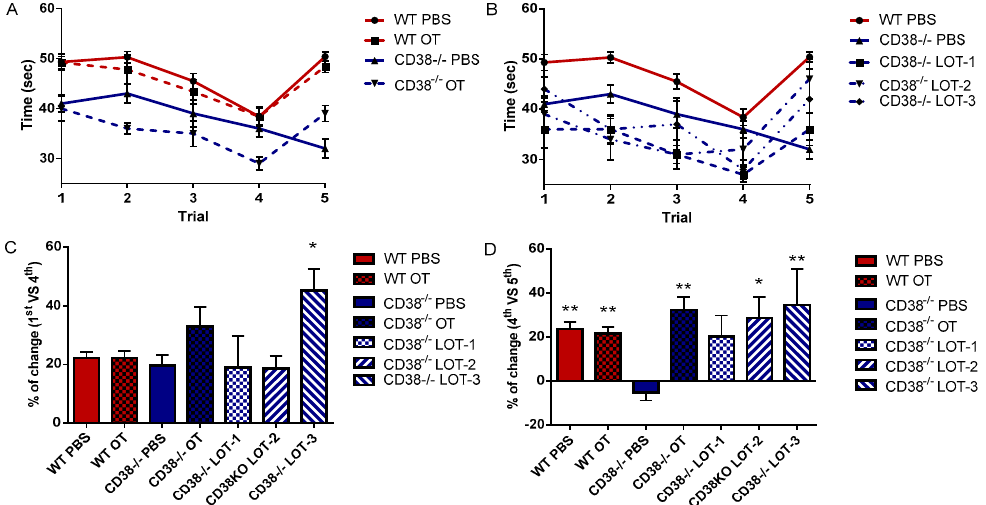
Figure 3. Rapid test of social acquisition and recognition. The time spent for social investigation in